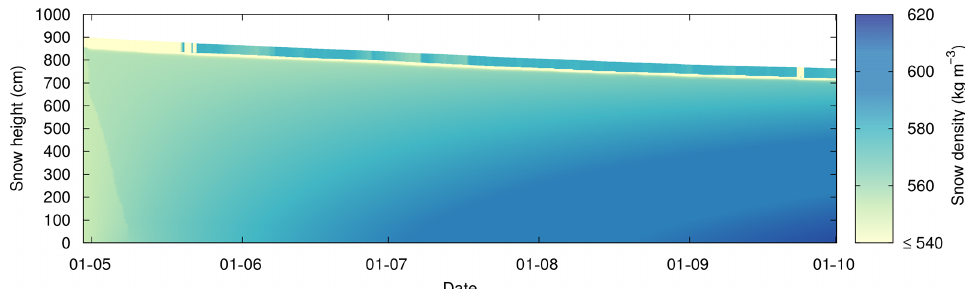
Figure 8. Simulated temporal evolution of snow height and snow density at the Flüela snow